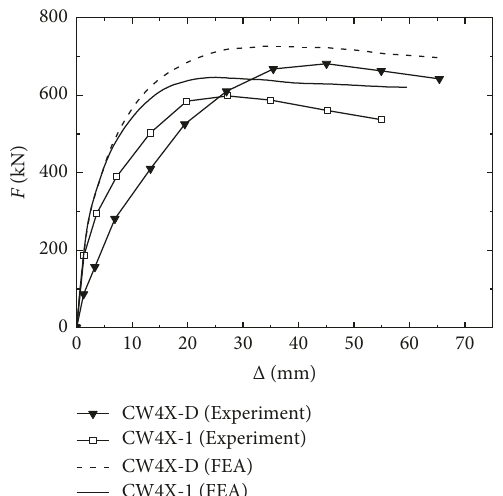
Figure 14: Comparison of hysteretic curves between experiment and FEA.